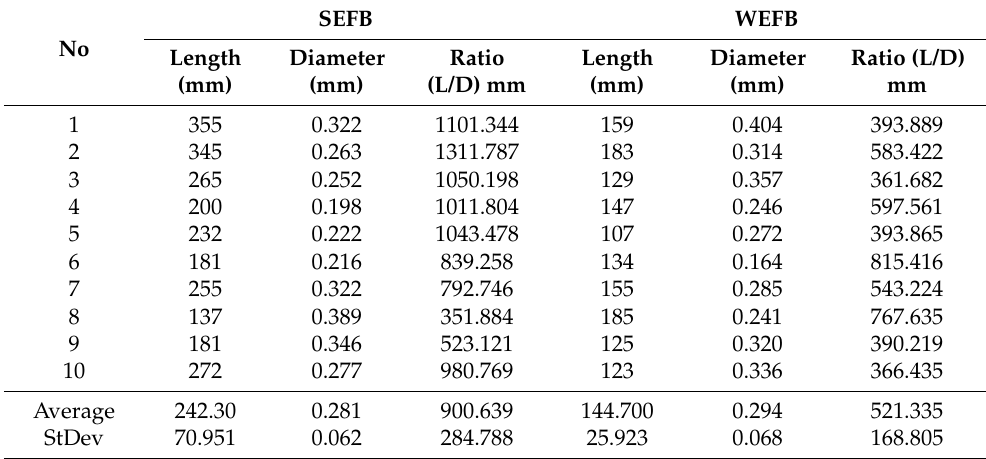
Table 5. Fiber dimensions of whole-empty fruit bunches (WEFB) and stalk-empty fruit bunches